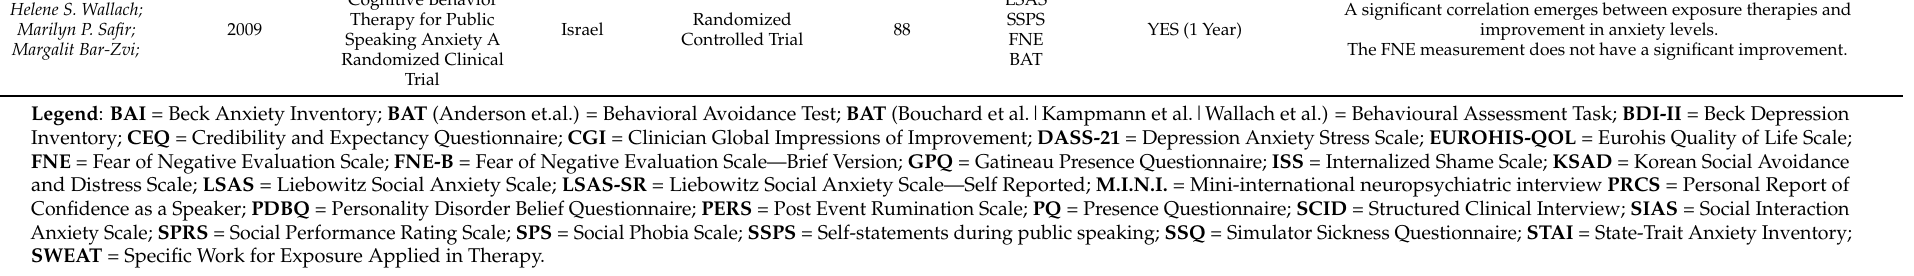
A significant correlation emerges between exposure therapies and improvement in anxiety levels. The FNE measurement does not have a significant